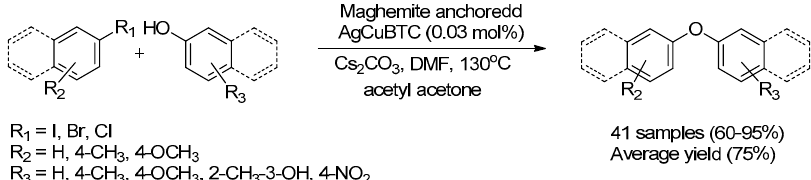
Table 8. The comparison of a single catalyst and with a combined catalyst in the Ullmann O- arylation reaction. Centre Catalyst Loading Yield (%)